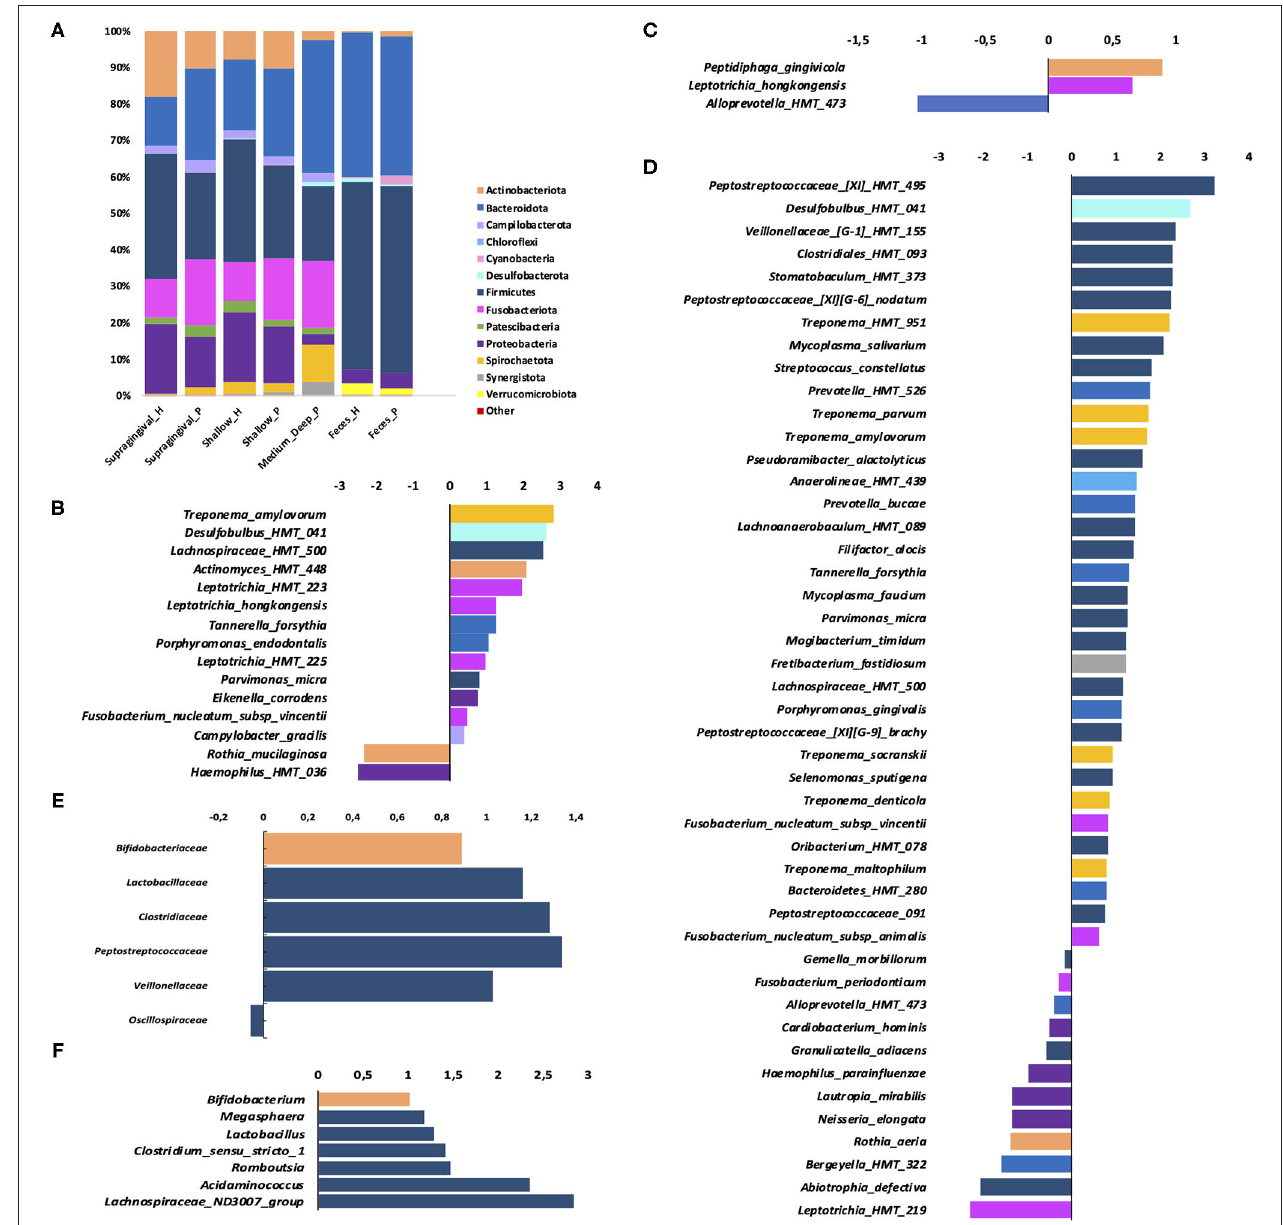
FIGURE 3 | Phylum distribution in samples of the oral sites and feces (A) ; (B–D) : Fold changes (log 2 ) relative abundance of species in periodontitis samples (positive values) compared to control (negative values)—in: (B) supragingival biofilm (C) subgingival non- affected sites of periodontitis patients and health patients; (D) subgingival affected sites of periodontitis patients compared to subgingival sites of H; (E) fold changes of Relative abundance of families in feces and (F) genera in feces. Only species which the relative abundance differed between P and H (B–D) are shown (Wilcoxon-Mann Whitney test, p ≤